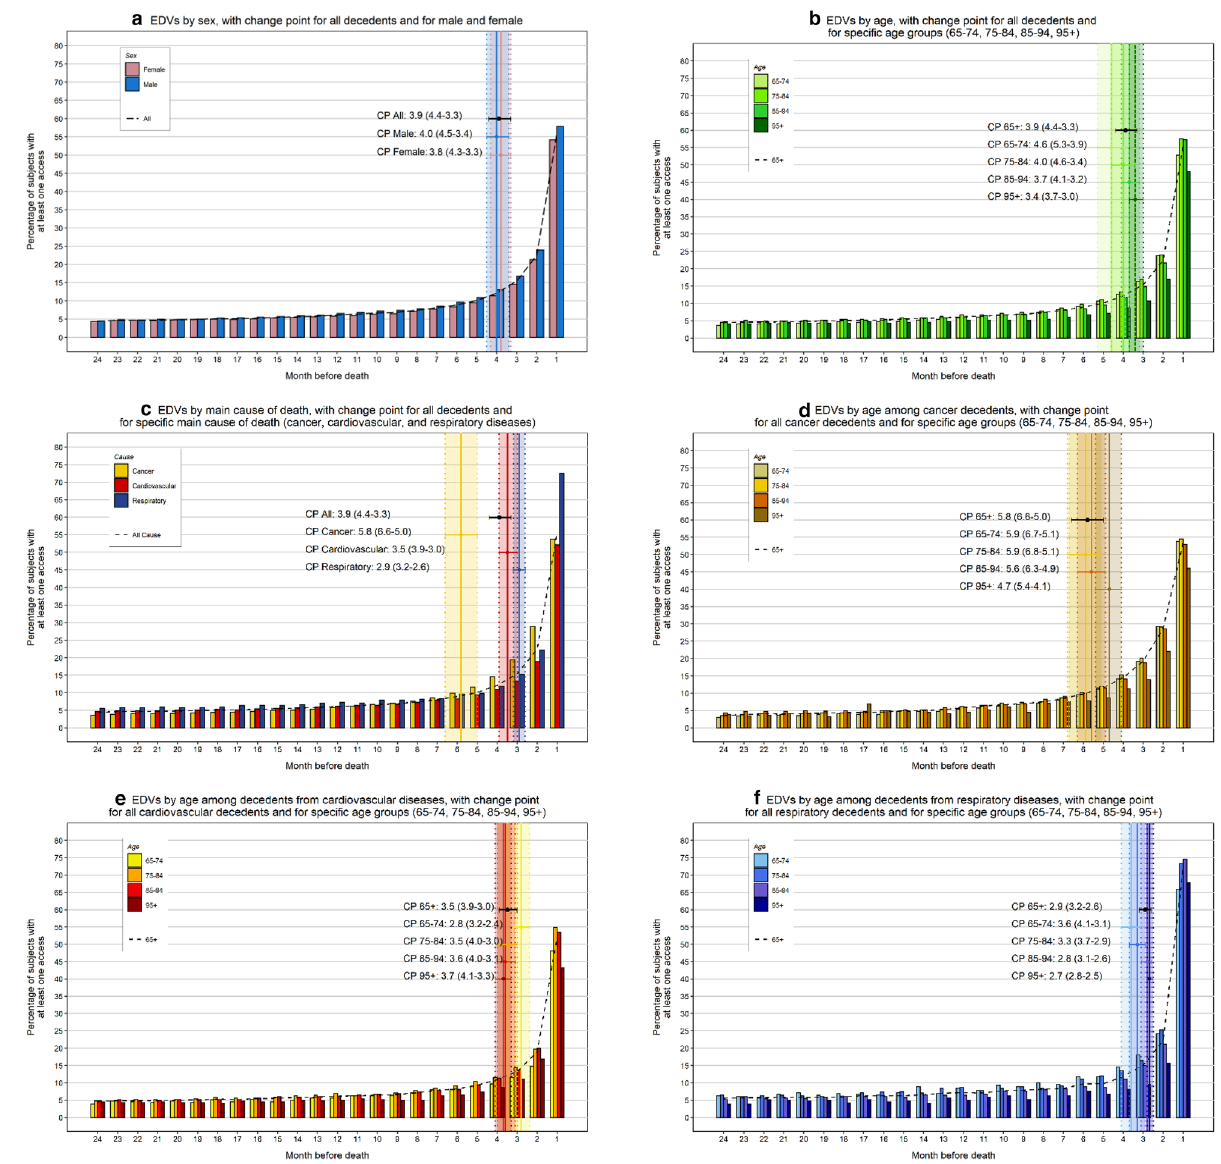
Figure 2. Proportion of decedents with an emergency department visit (EDV), stratified by sex, age and main cause of death in the 24 months preceding death, with specific change-point month and 95% confidence